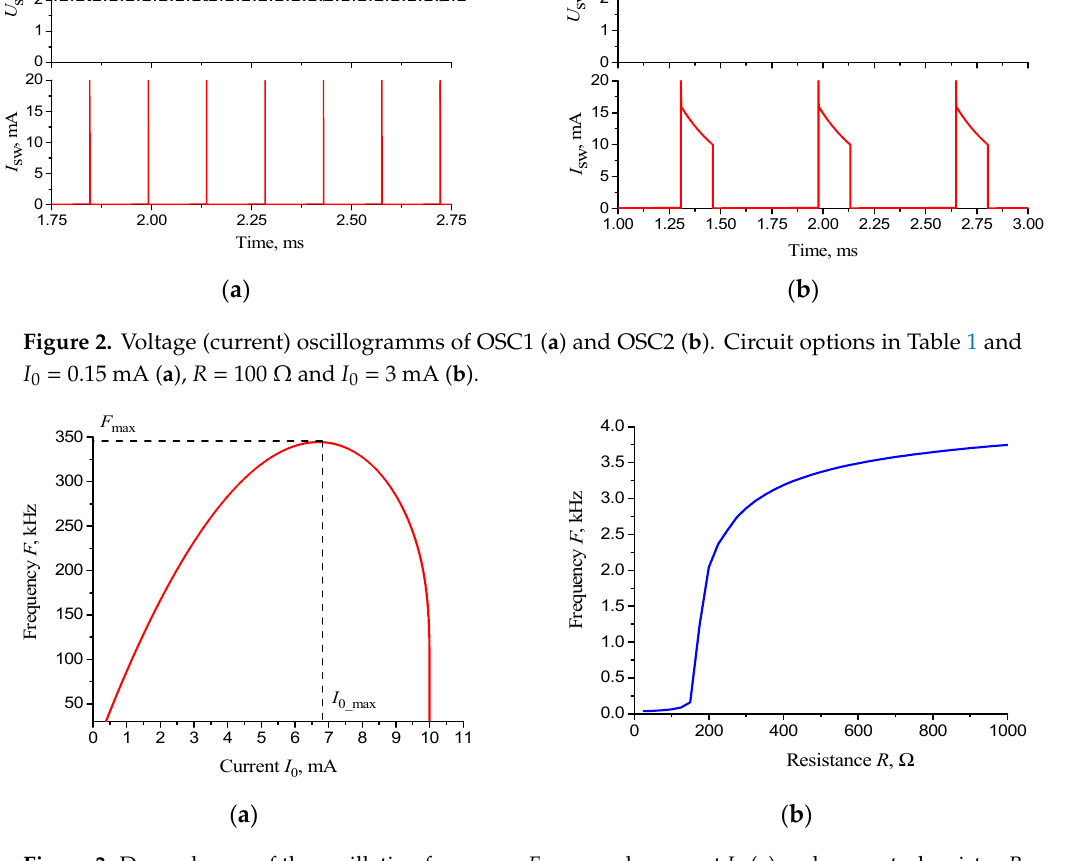
Figure 3. Dependences of the oscillation frequency F on supply current I 0 ( a ) and on control resistor R ( b ) of OSC1 and OSC2, respectively.